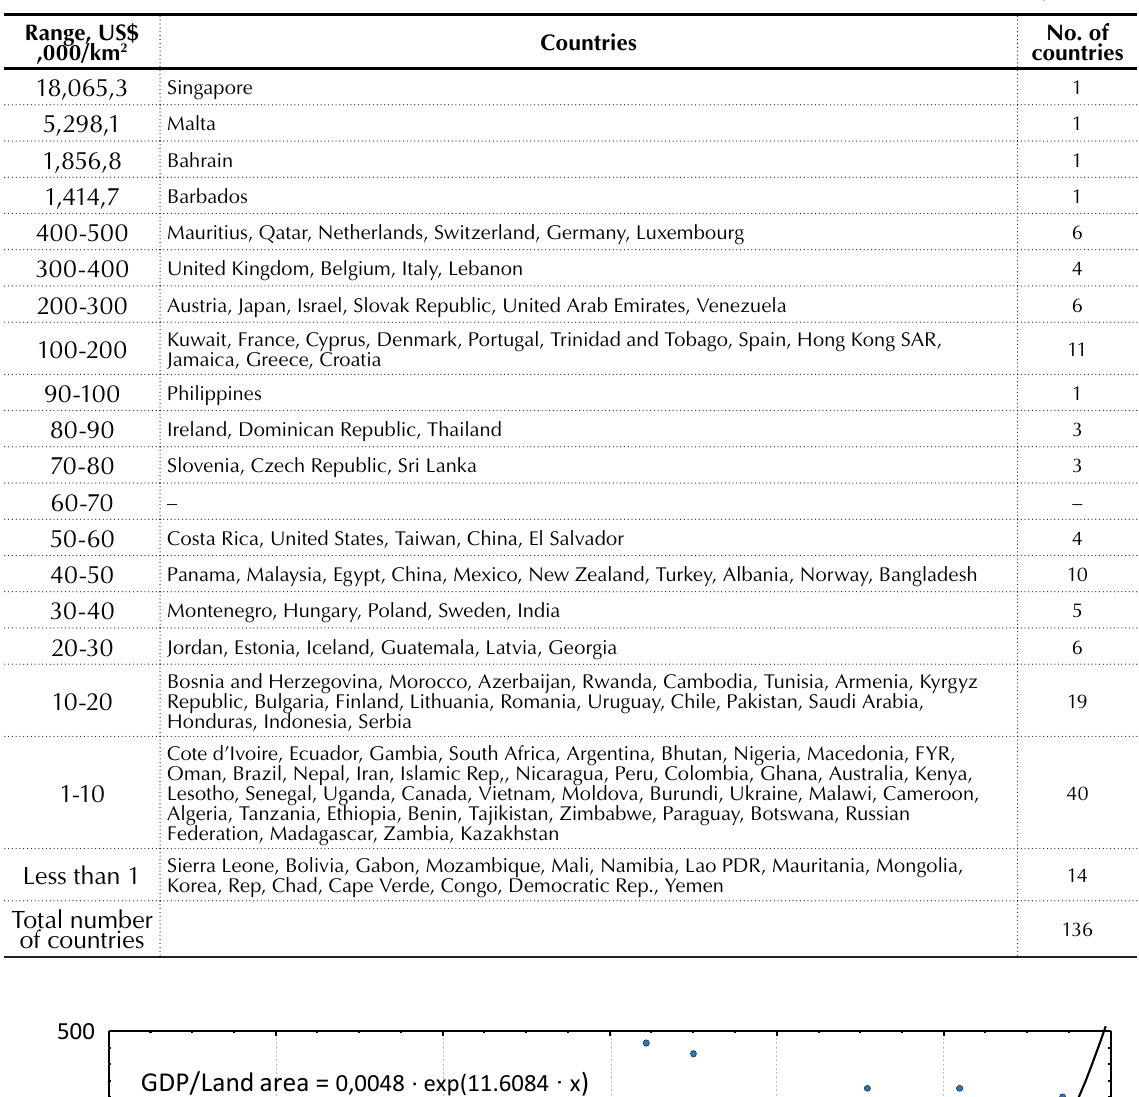
Source: Data from WTTC, World Bank.